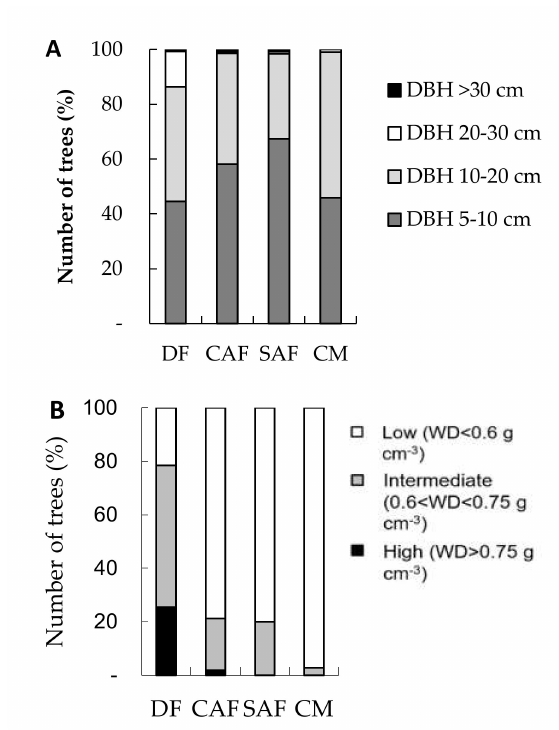
Figure 2. ( A ) The distribution of tree diameter for degraded forest (DF), cacao complex agroforestry (CAF), cacao simple agroforestry (SAF), and cacao monoculture (CM); ( B ) Number of trees based on wood density (WD)